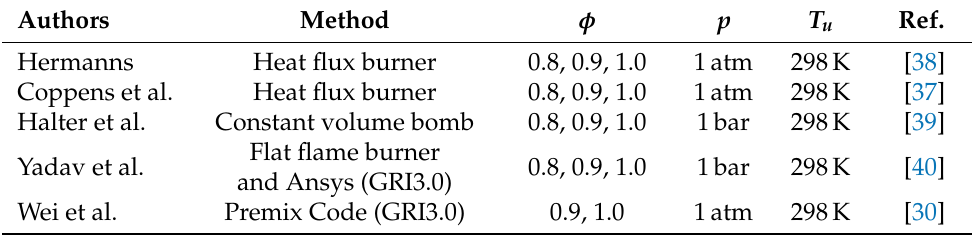
Table 2. Published work on laminar flame speed of lean CH the correlation of this